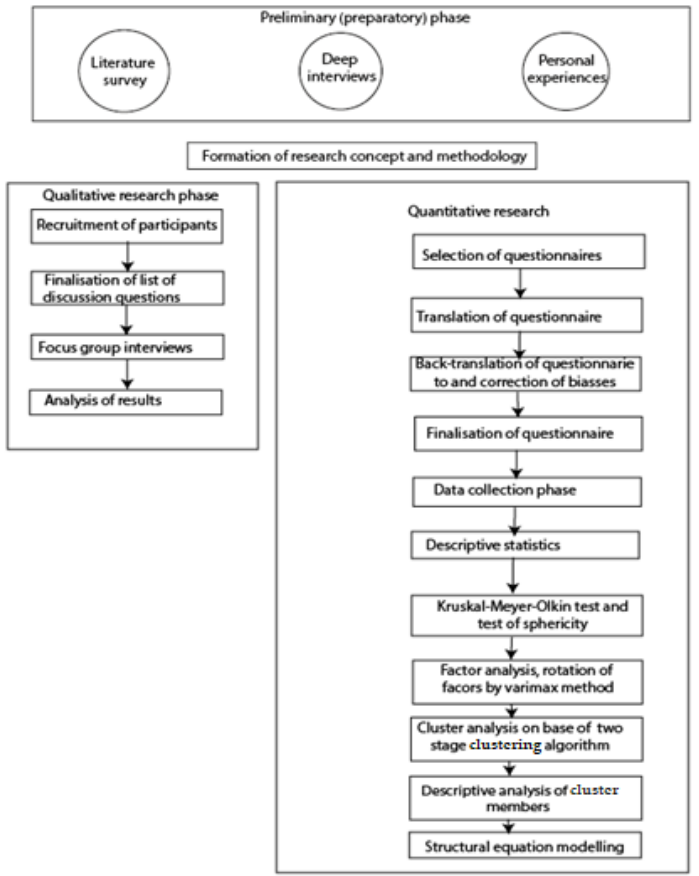
Figure 2. Flowchart of the investigations. The overwhelming majority of trainers and dietitians are active in community media, because this is the main channel of promotion by keeping regular contact with their clients and peers. This vibrant ecosystem of trainers has been used to contact them and recruit the participants of the survey by using the direct-contact and the snowball methods.